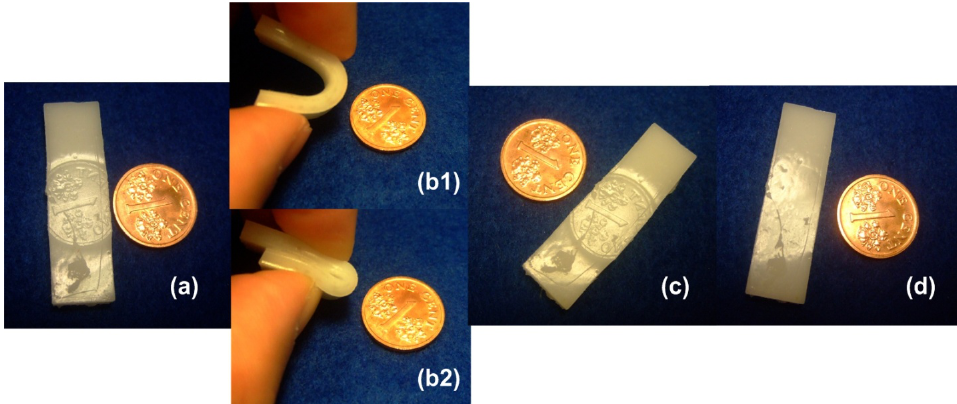
Figure 26. Rubber-like polymeric anti-counterfeit label. ( a ) After impressing using a coin at high temperatures; ( b ) in bending; ( c ) after severe bending; and ( d ) after heating for shape recovery.